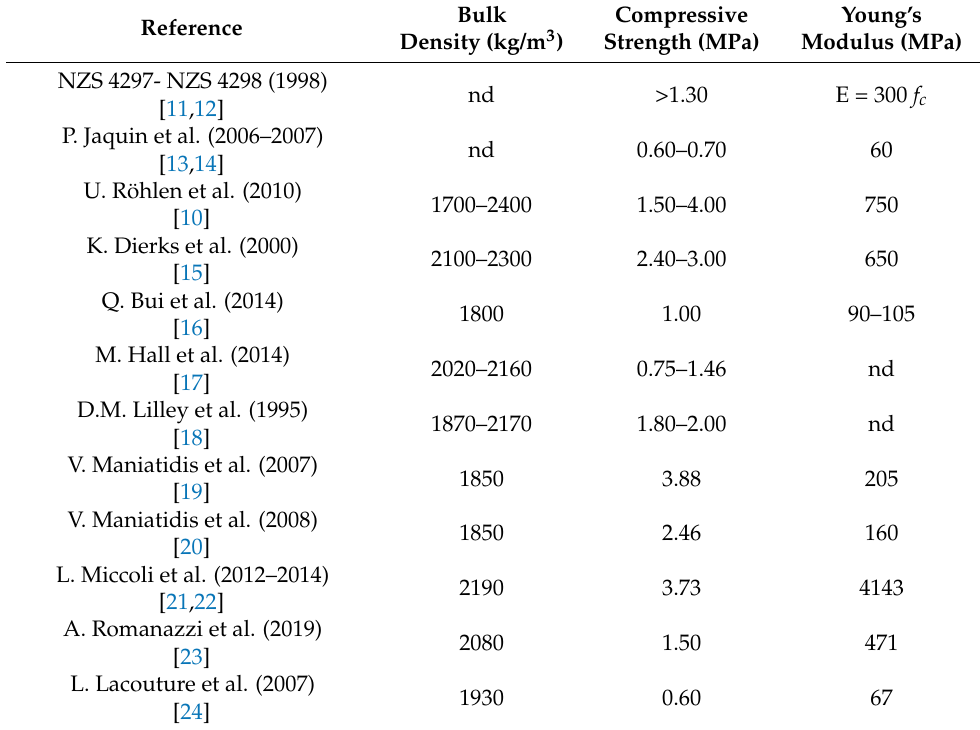
Table 1. Material properties for rammed earth from the literature.